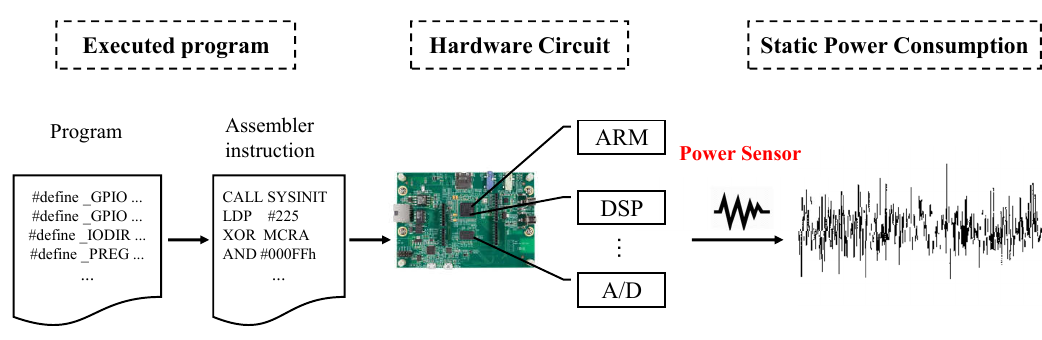
Figure 2. The correlation between the executed program and power signal from the perspective of the Physical Principle. The instructions flip the transistors in the DSP, ARM processor, and other chips gate circuits, resulting in the change of static power